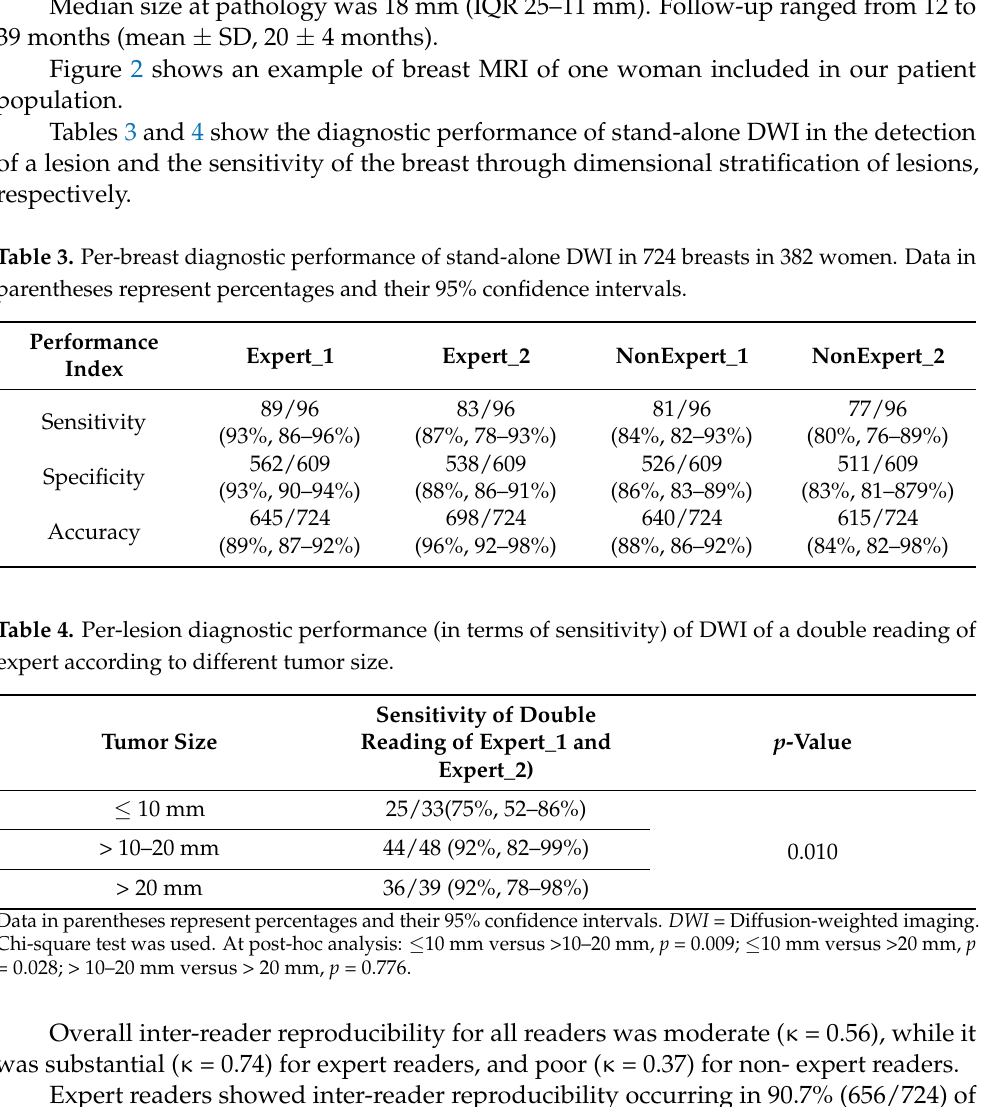
Data in parentheses represent percentages and their 95% confidence intervals. DWI = Diffusion-weighted imaging. Chi-square test was used. At post-hoc analysis: ≤ 10 mm versus >10–20 mm, p = 0.009; ≤ 10 mm versus >20 mm,